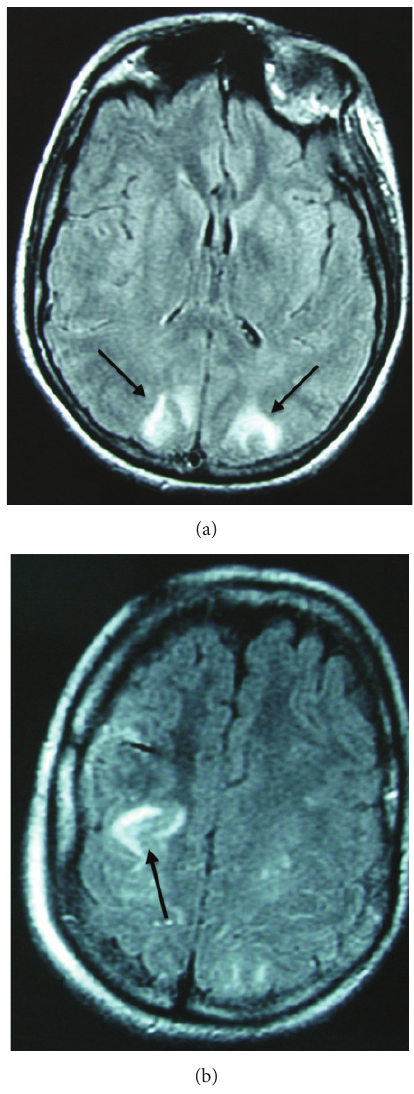
Figure 2: (a) Fluid attenuated inversion recovery magnetic res- onance imaging indicating high signal lesions on both occipitals lobes. (b) Fluid attenuated inversion recovery magnetic resonance imaging indicating high signal lesions on the right parietal